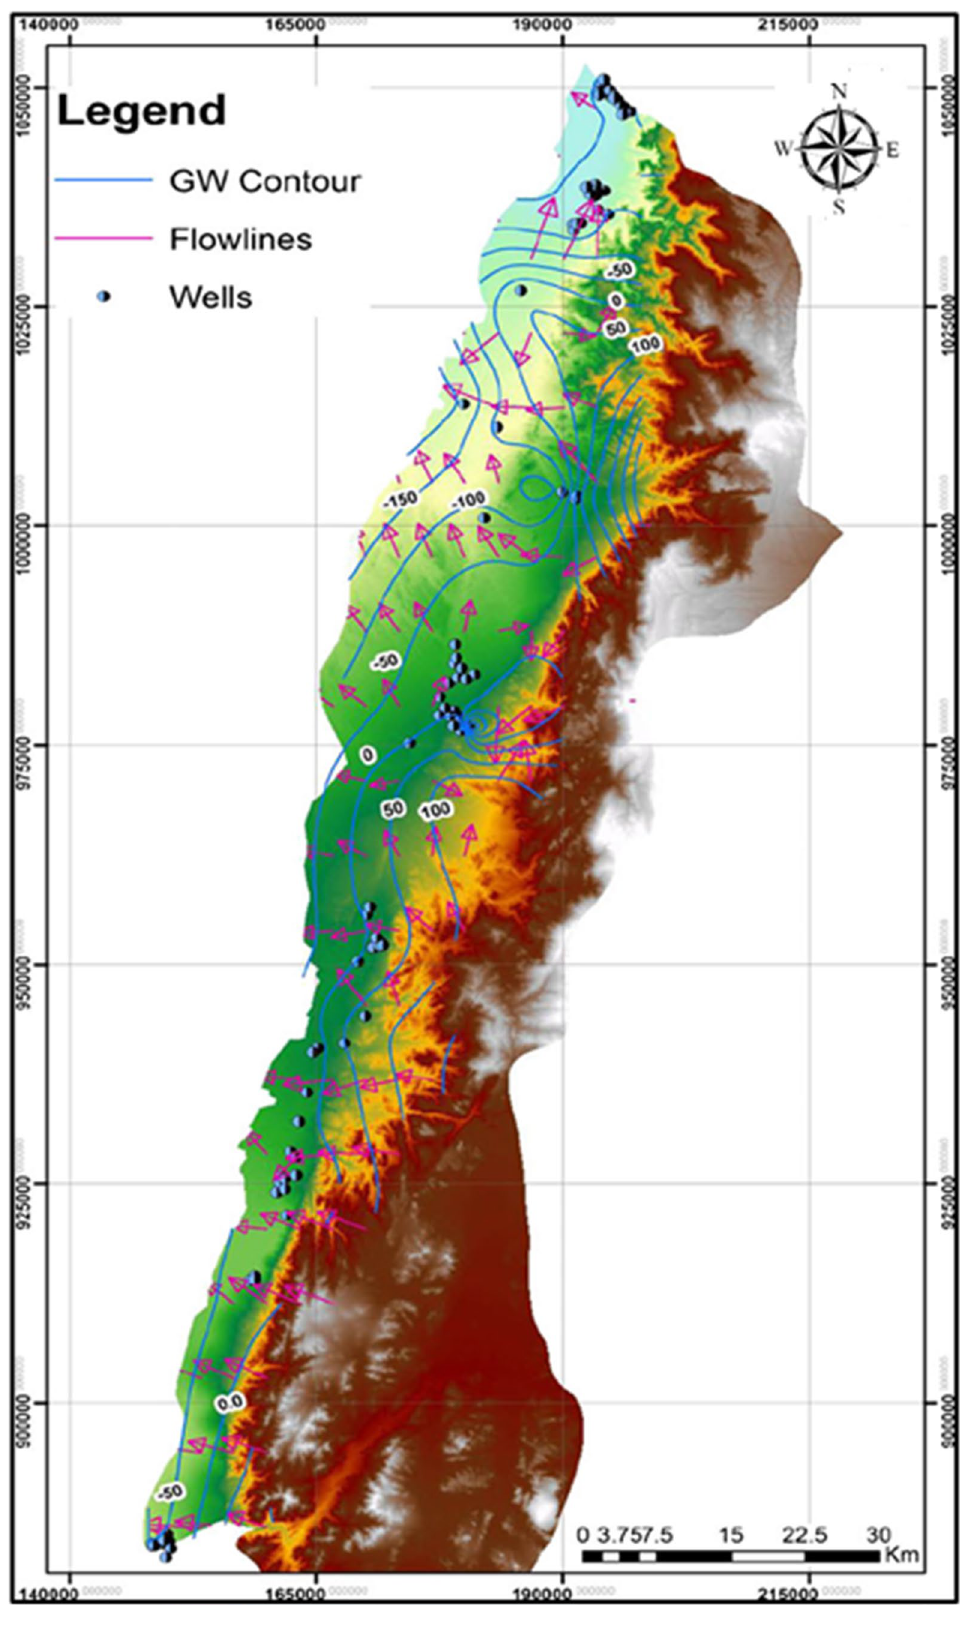
Fig. 4 Groundwater flow direction map of alluvial aquifer system8 (El-Naqa and Al Kuisi